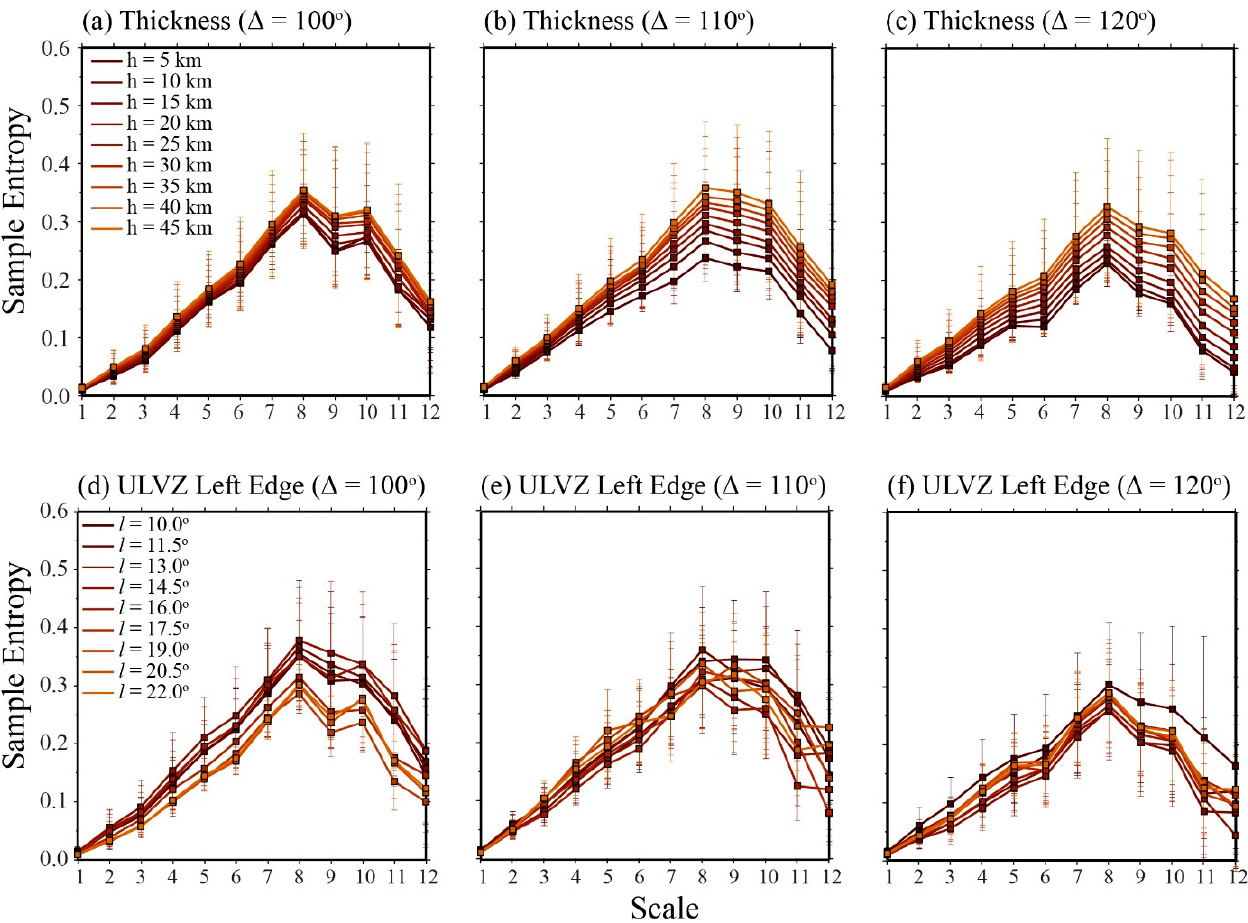
Figure 14. Sample entropy as function of scale. In panels ( a – c ), the sample entropy is averaged for all 2.5-D ULVZ models based on ULVZ thickness. Here, the thickness varies from h = 5 km to 45 km in 5 km increments. Mean (squares) and standard deviation (error bars) are shown. Measurements are shown for synthetic seismograms at epicentral distances of ( a ) 100°, ( b ) 110°, and ( c ) 120°. In panels ( d – f ), the sample entropy is averaged for all 2.5-D ULVZ models based on ULVZ left edge position. Positions vary from l = 10.0° to 22.0° in 1.5° increments. Measurements are shown for synthetic seismograms at epicentral distances of ( d ) 100°, ( e ) 110°, and ( c ) 120°.